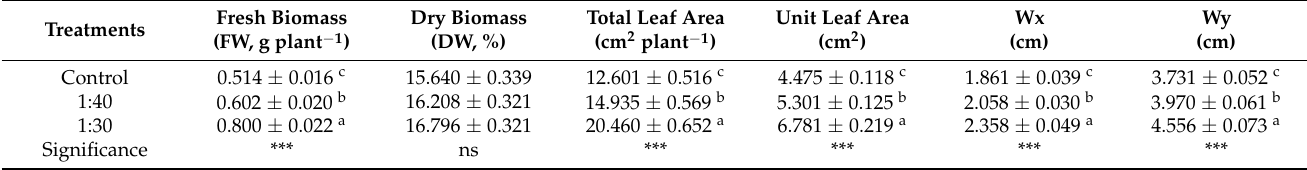
Table 1. Effect of Moringa oleifera leaf extract (MLE) foliar application on fresh and dry biomass (FW, g plant − 1 ), total leaf area (cm 2 plant − 1 ), unit leaf area (cm − 2 ), and land leaf dimension (Wx and Wy) (cm) of radish baby leaf. MLE extract was sprayed 15 and 30 days after planting and 2 days before harvesting (45 days after planting).